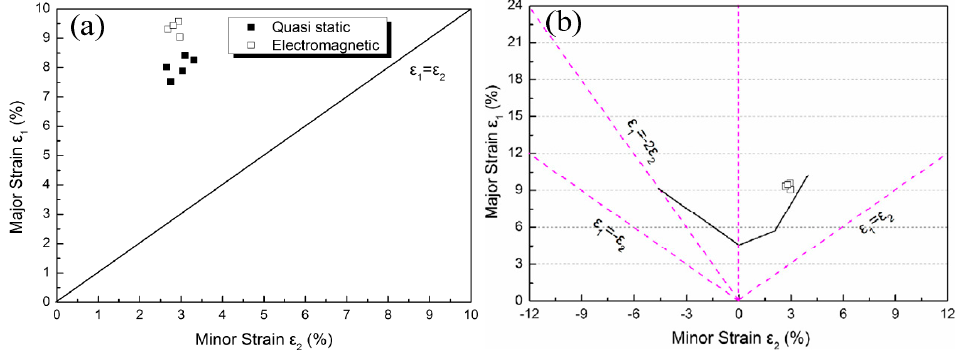
Figure 7. Comparison of formability of Ti-6Al-4V sheets in quasi static ( a ) and EMF ( b ) [57]. Reprinted with permission from Ref. [57]. Copyright 2013, Mater. Design.